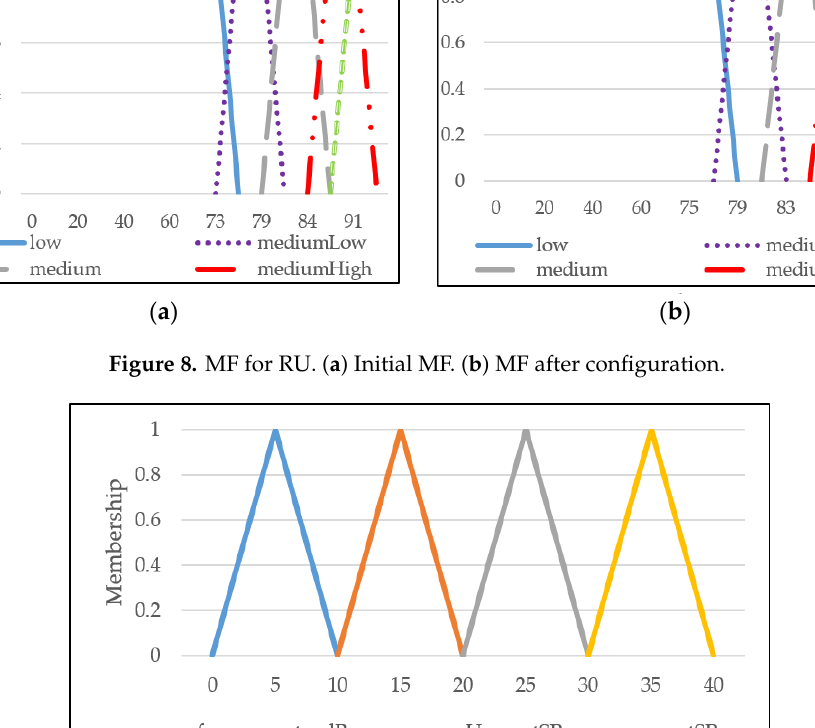
Table 10. Scenario for energy efficiency.